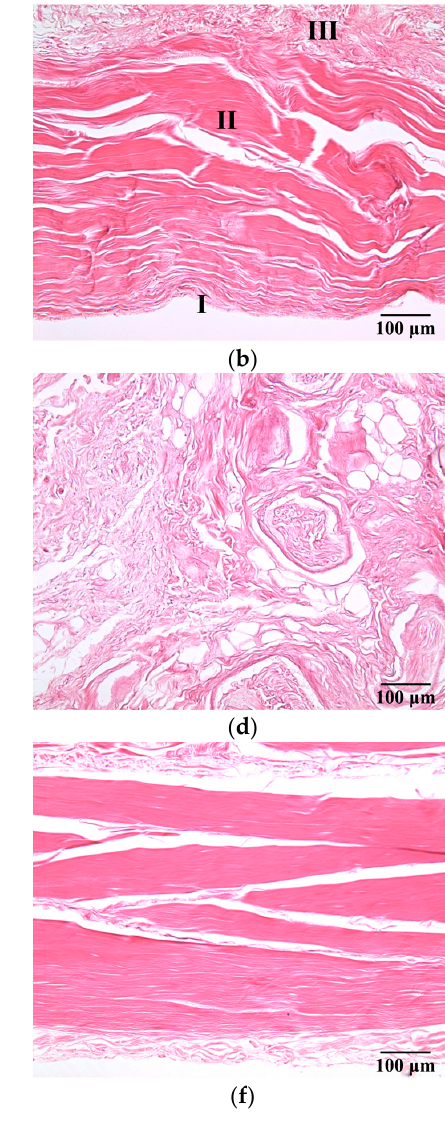
Figure 3. H&E-stained sections of ( a ) hypodermis; ( b ) A1 pulley; and ( c ) SDFT were sliced in the sagittal plane, and those sliced in the transverse plane corresponded to ( d ) to ( f ). (100× magnification). The symbols C and A indicate the connective tissue and adipose lobules in the hypodermis, respectively. The pulley is made up of three layers: I = innermost layer, II = middle layer, III = outermost layer. The symbols F and S indicate the connective tissue sheath and fascicle in the SDFT, respectively.